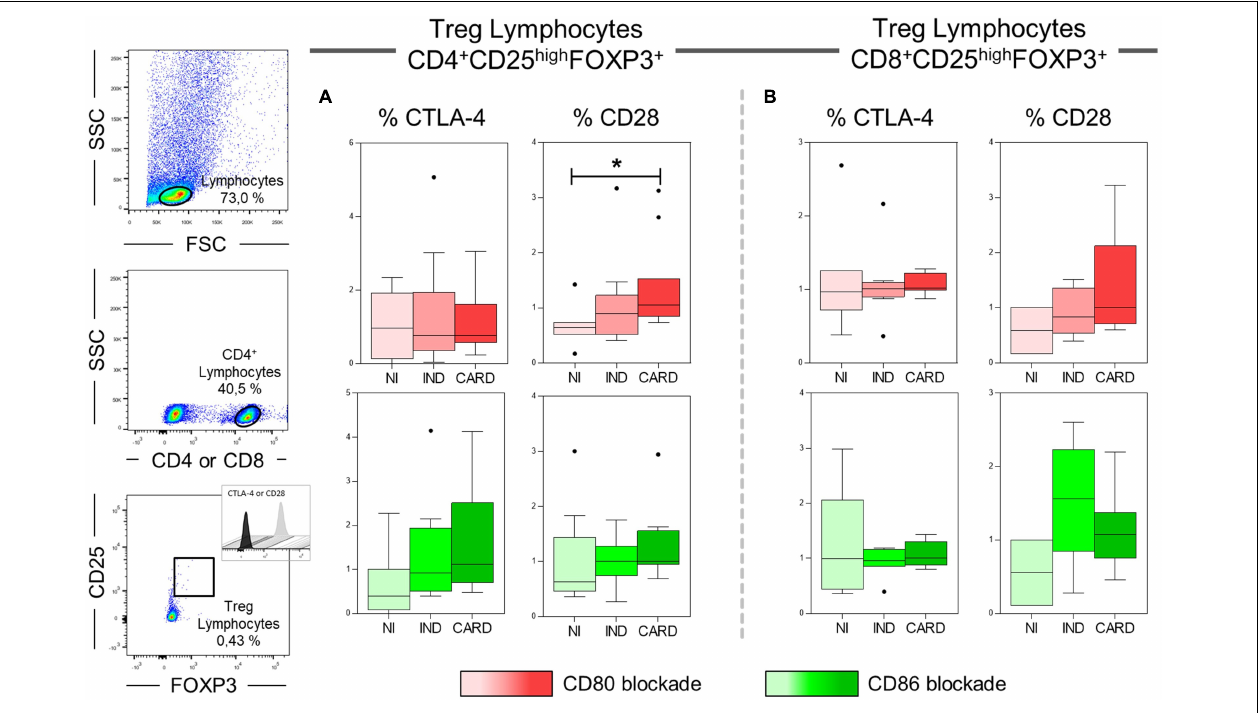
FIGURE 6 | Analysis of the frequency of CD28 and CTLA-4 ligands on Treg lymphocytes after anti-CD80 and anti-CD86 antibody blockade. Flow cytometry gate strategy of non-infected (NI) individuals is represented. Frequency of T CD4 + Treg lymphocytes (A) and CD8 + Treg lymphocytes (B) expressing CD28 and CTLA-4 in PBMC culture from NI individuals ( n = 9), indeterminate (IND, n = 9), and cardiac (CARD, n = 11) clinical forms of Chagas disease, after in vitro stimulation with T. cruzi antigens and anti-CD80 and anti-CD86 antibody blockade. Statistical differences ( p < 0.05) between groups were obtained by Kruskal–Wallis test, followed by Dunn’s post-test, and represented by asterisk (*) and lines. Boxes demonstrate the median and interquartile ranges, whiskers evidence the highest and lowest observation, and dots represent the